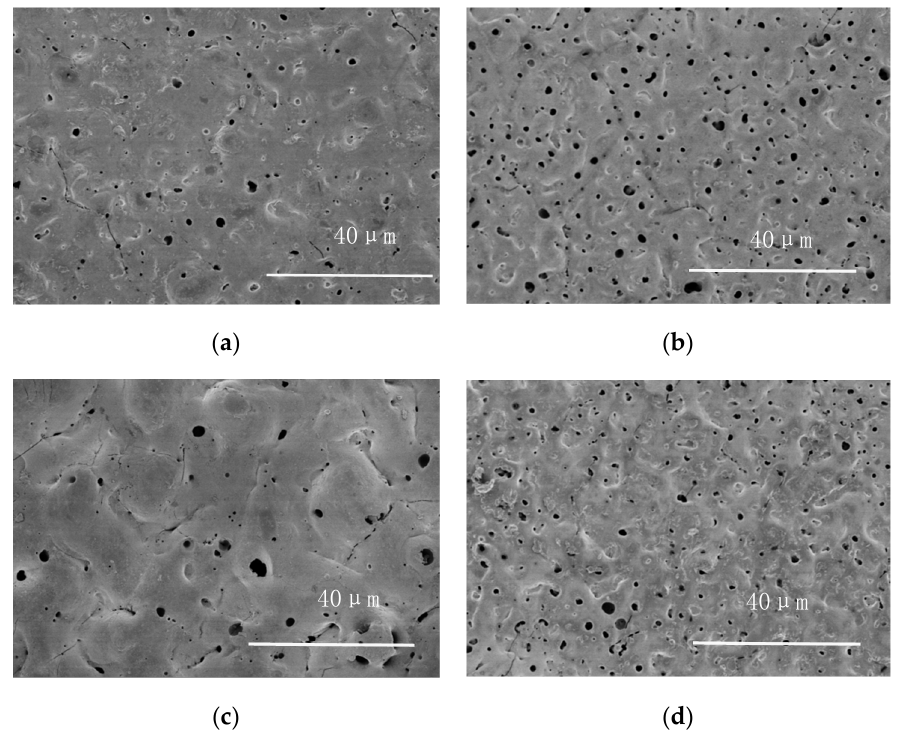
Figure 7. SEM images of PEO coatings ( a ) optimal condition, ( b ) test 3, ( c ) test 4 and ( d ) test 5. Optimal conditions are: electrolyte compositions of 45 g/L NaOH, 50 g/L Na 2 SiO 3 and 90 g/L Na 2 B 4 O 7 with electric parameters of current density 1 A/dm 2 ; pulse frequency 200 Hz; duty cycle 10% and oxidation time 15 min.